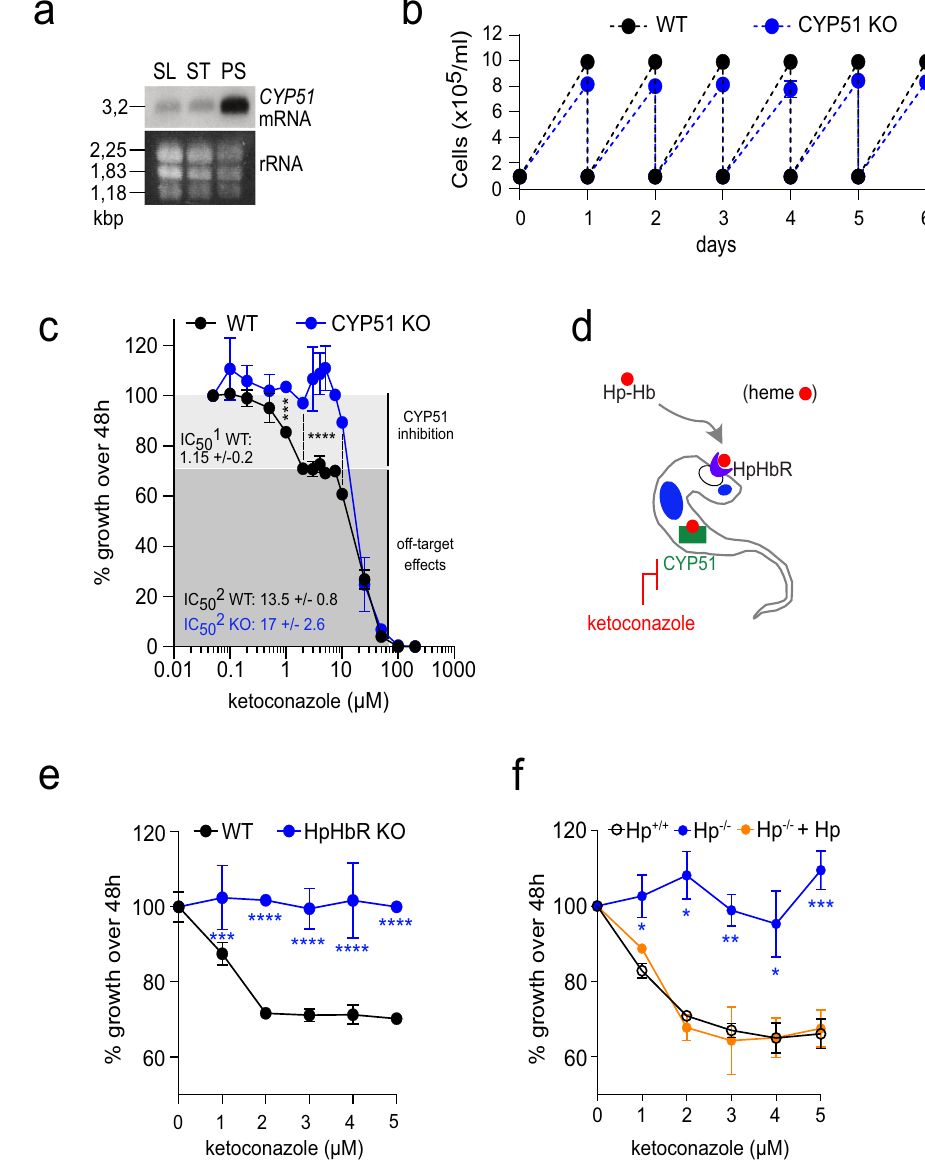
Fig. 2 | Effect on growth and ketoconazole sensitivityafter CYP51 invalidation in the bloodstream stage. a Northern blot analysis showing stage-speci fi c expression of CYP51 mRNA. Total RNA from long slender (SL) and stumpy (ST) bloodstreamstage,andprocyclicstage(PS)washybridizedwiththe Tb CYP51DNA probe. The staining of ribosomal (r)RNA was used as a loading control. b Growth curves of WT T. b. brucei (black dots and line) and CYP51 knock-out (CYP51 KO) (bluedotsandline)for6days. c ThedepletionofCYP51confersinsensitivitytolow dosesofketoconazole.WT(blackdotsandline)andCYP51KOcells(bluedotsand line) were grown under the same conditions. A light gray zone indicates con- centrations of ketoconazole with an inhibitory effect on CYP51, and a dark gray zone indicates a concentration range with an off-target effect ( n =3). Sidak ’ s multiplecomparisonstest*** p <0.001;**** p <0.0001. d Schematicrepresentation